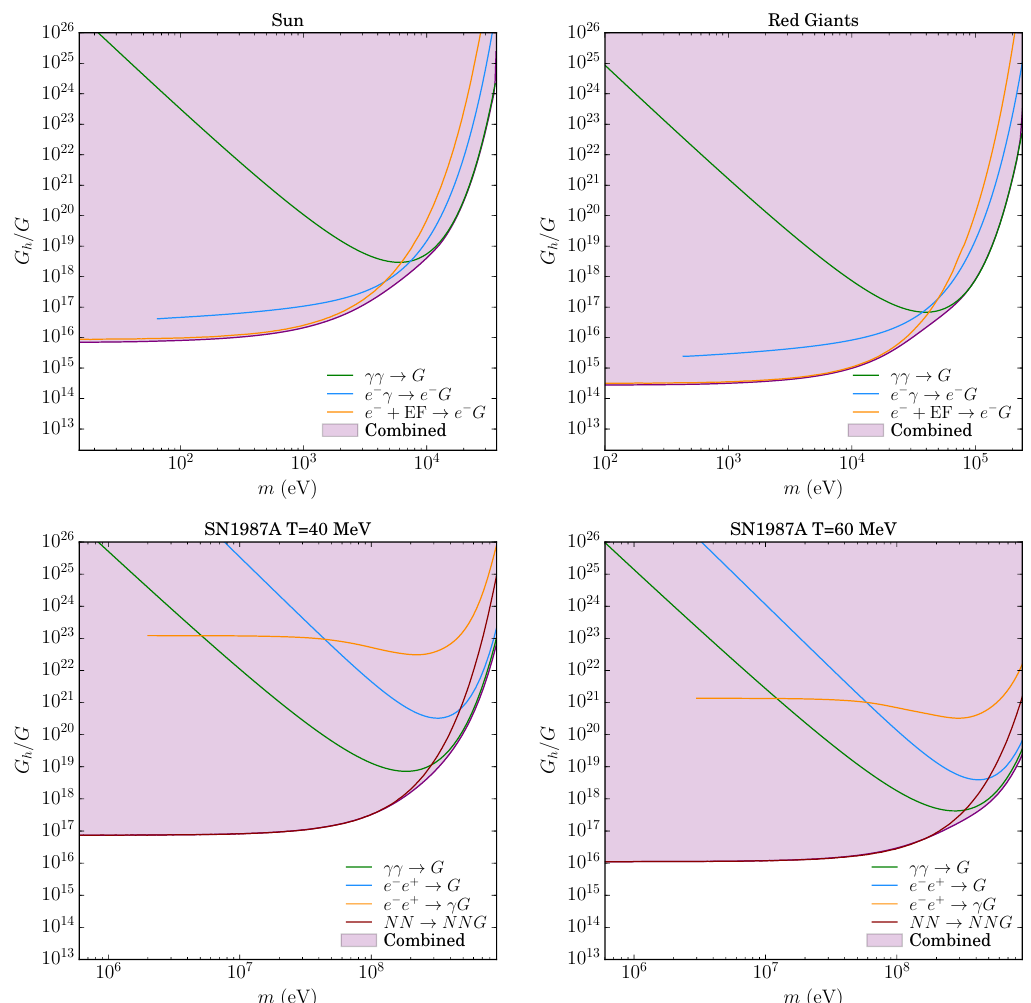
Figure 5 . Constraints coming from the processes considered under di(cid:11)erent astrophysical condi- tions, along with the combined bounds for each object. The shadowed region is excluded. In the supernova case, as there is uncertainty about its temperature, we plot the results for two di(cid:11)erent temperatures. For the (cid:12)nal limits we will use the more conservative estimate of T = 40